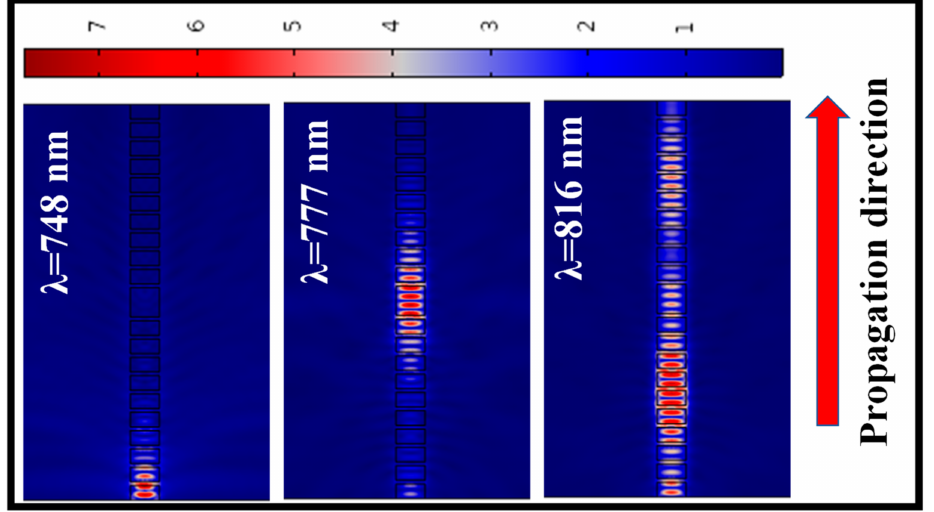
Figure 15. E-field distribution in the FP-structure at λ = 748 nm ( left ), λ = 777 nm ( middle ), and λ = 816 nm ( right ). Geometric parameters used in the analysis are as follows: DC = 80%, W = 800 nm, N =